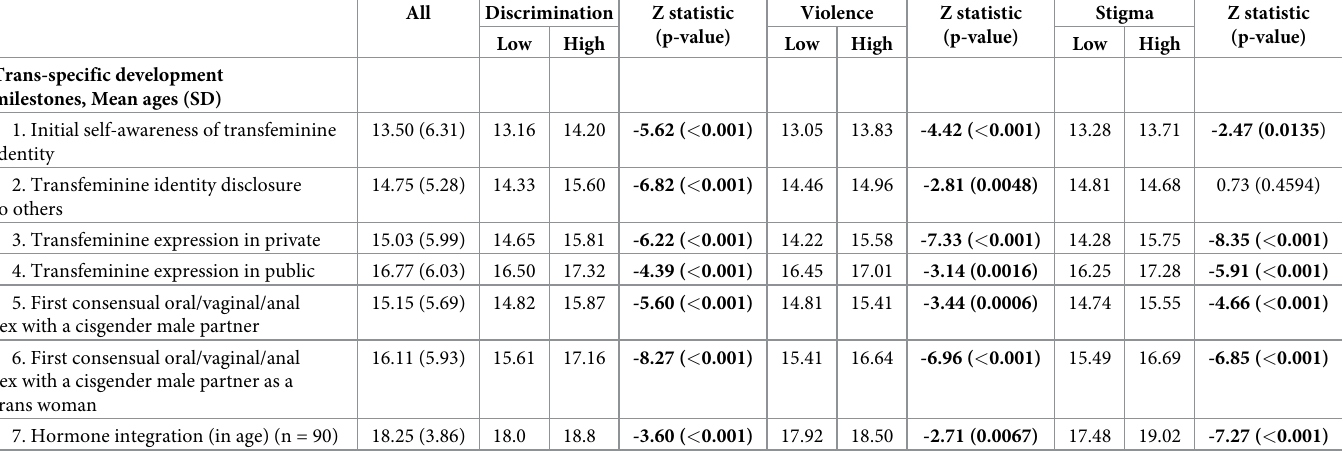
Table 2. Trans-specific development milestones and experiences of discrimination, stigma, and violence (n =